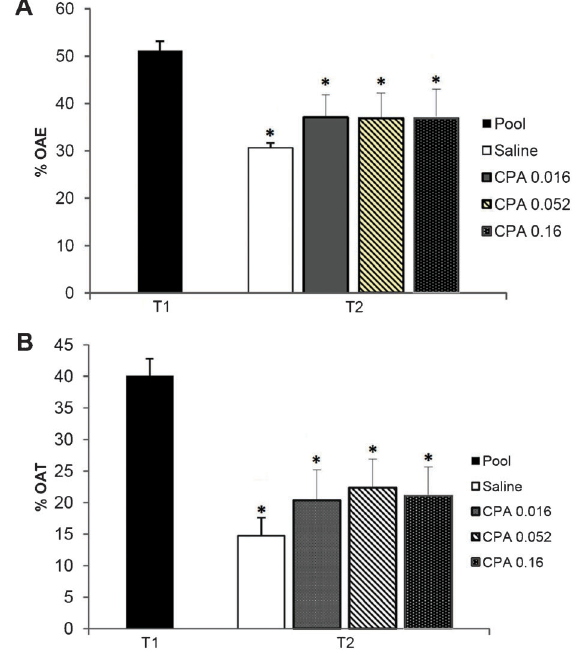
Figure 2. Effects of H1 antagonist chlorpheniramine (CPA; 0.016, 0.052, or 0.16 nmol/0.1 m L) microinjected into the cere- bellar vermis on A , the percentage of open-arm entries (%OAE) and B , the percentage of time spent in the open arms (%OAT) in Trials 1 and 2 in the elevated plus maze. Pool: animals exposed to the elevated plus maze with no pharmacological treatment. Data are reported as means±SE (n=9). *P , 0.05 Trial 2 vs Trial 1 (Duncan test).